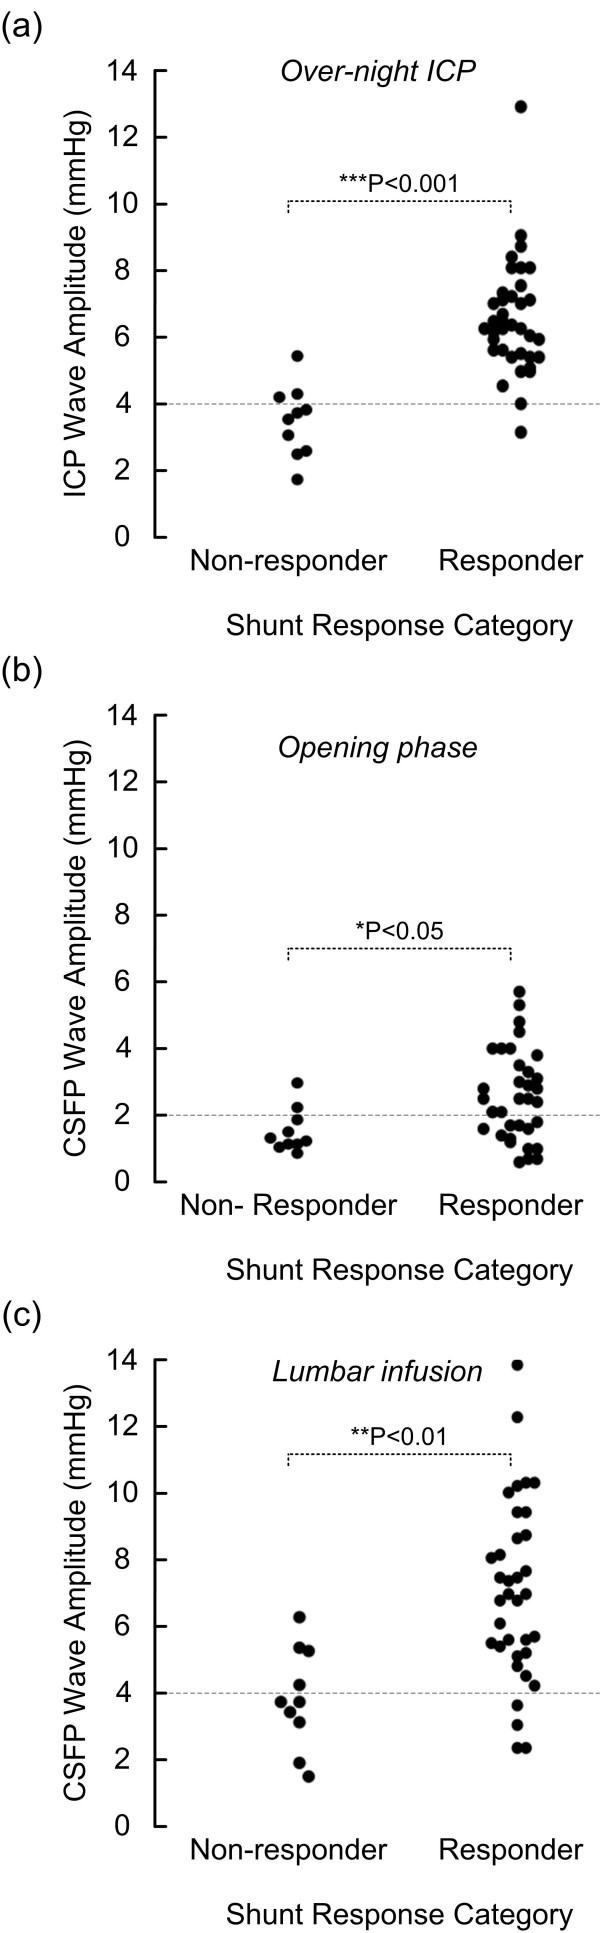
Scatter plots of mean CSFP wave amplitude for shunt response categories non-responder and responder during (a) over-night ICP monitoring, (b) during the opening phase after lumbar puncture, and (c) during the phase of lumbar infusion. Dotted lines denote cut off targets for the pulsatile pressure (wave amplitude). The pulse amplitude during the opening phase of lumbar puncture was not as good a predictor for shunt response as the amplitude during overnight monitoring and during lumbar infusion. Significant differences between responders and non-responders are shown (one-way ANOVA).